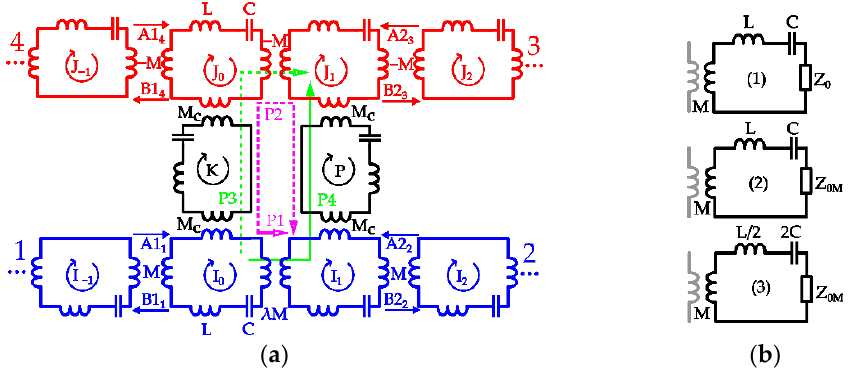
Figure 2. ( a ) MI directional filter equivalent circuit; ( b ) lumped element terminations: (1) magnetoinductive, (2) resistive, and (3) broadband resistive.